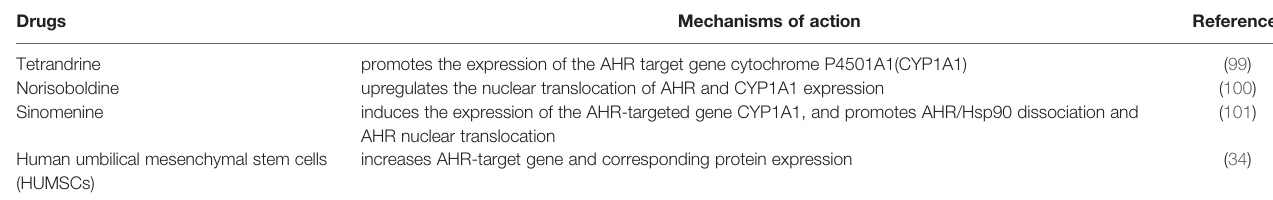
TABLE 1 | Novel agents in RA treatment targeting